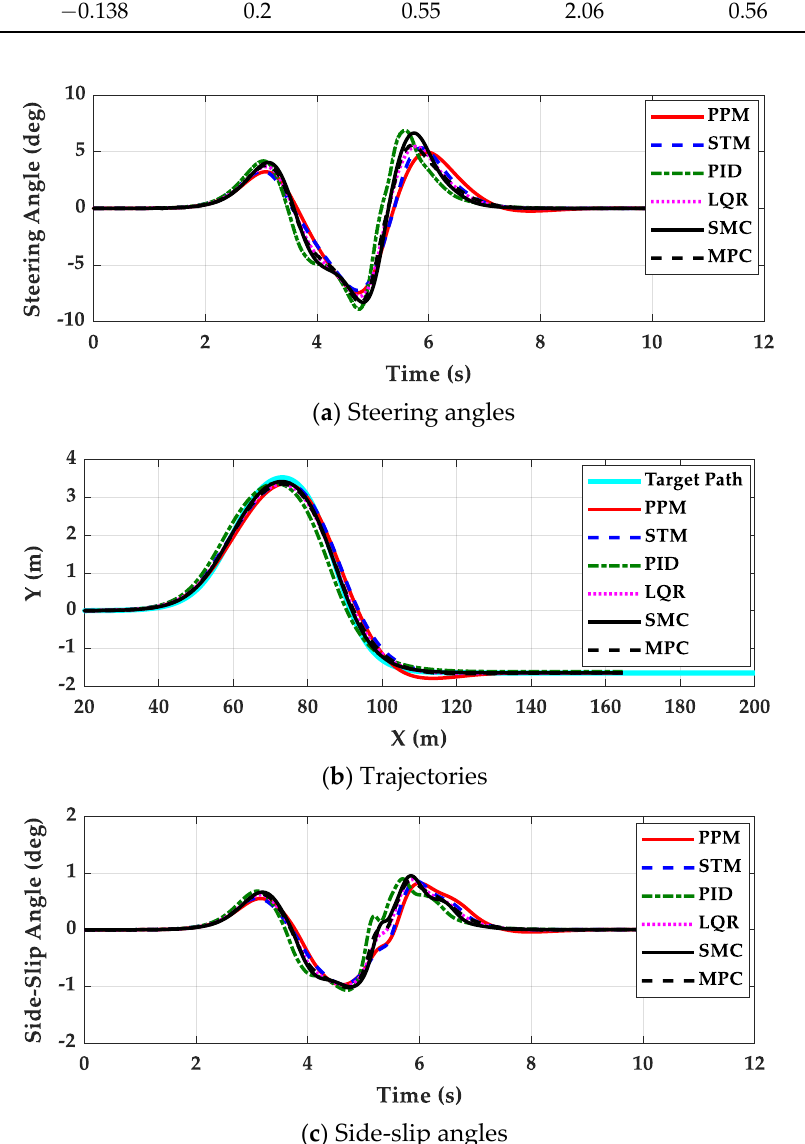
Figure 10. Simulation results of each controller for FWS vehicle on high- µ road obtained from the fourth set of